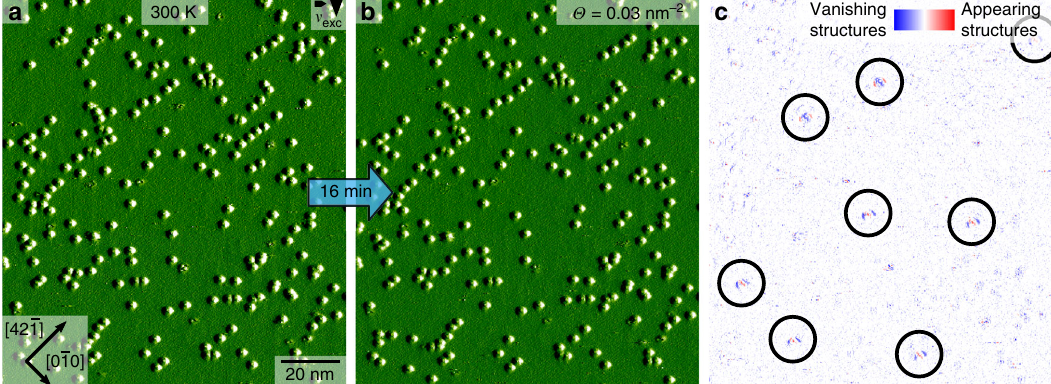
Fig. 4 Diffusion study of MoMo on calcite (10.4). a , b Two consecutive AFM images with a time lapse of 16 min of the same area. c Difference image of the images shown in a and b , illustrating that 8 (marked by black circles) out of 241 molecules change position along the 42 (cid:1) 1 (cid:1) (cid:3) molecules are found to move along the 0 (cid:1) 10 direction, which constitutes a clear sign of anisotropic diffusion. Blue and red colors label disappearing and appearing features, respectively. The sequence of three changes (blue, red, blue or red, blue, red) is a consequence of the fact that the molecules show a depression to